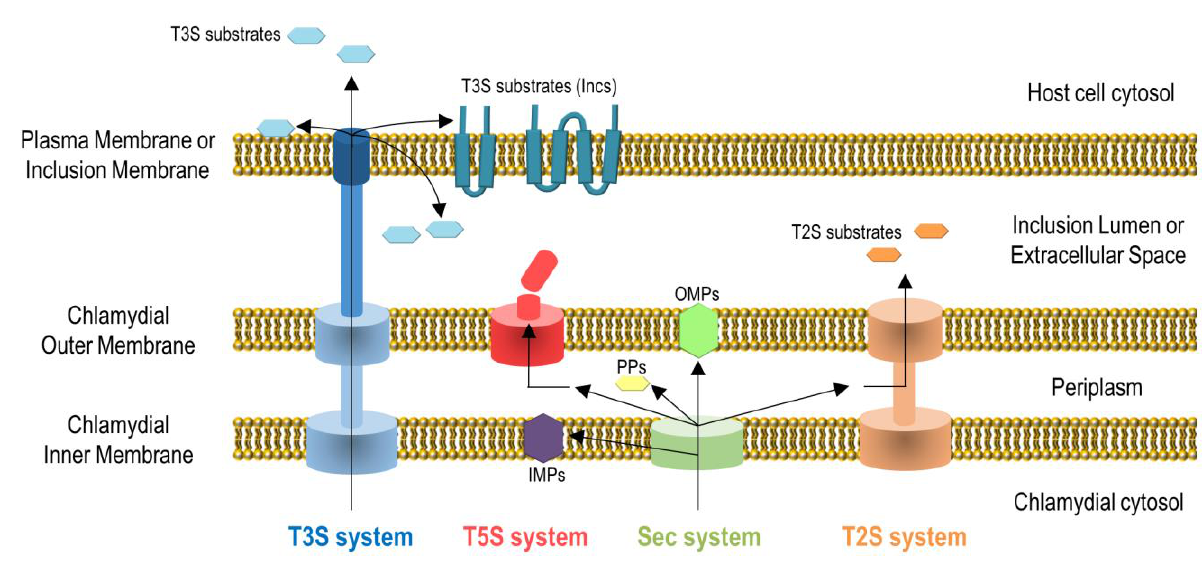
FIGURE 2: Secretion systems used by C. trachomatis to transport proteins to different aqueous and membranaceous chlamydial and host cell compartments. It is unclear how some chlamydial T3S substrates are transported into the inclusion lumen or how Incs insert into the inclusion membrane. IMPs, chlamydial inner membrane proteins; PPs, chlamydial periplasmic proteins; OMPs, chlamydial outer mem- brane proteins. See list of abbreviations and main text for